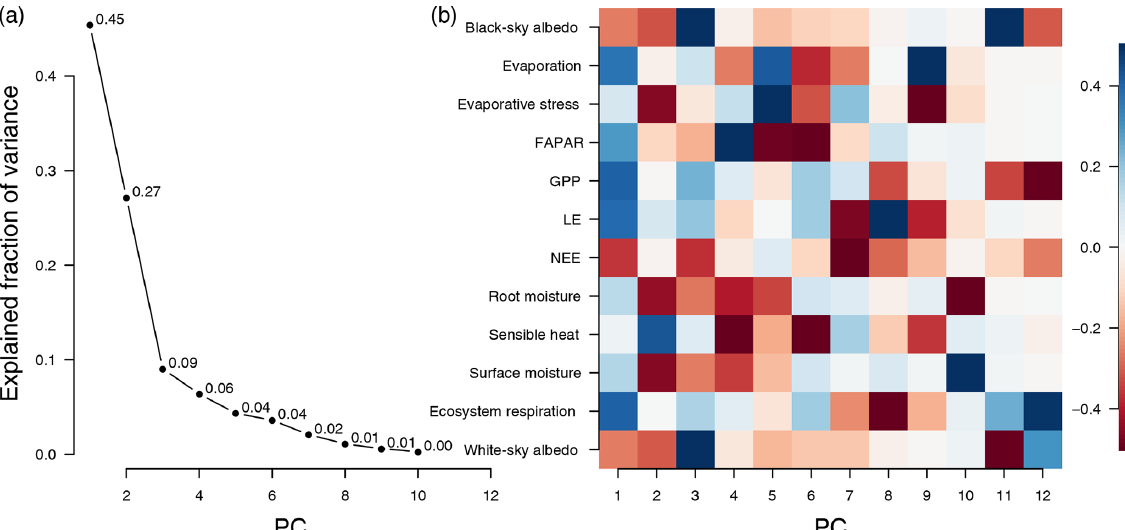
Figure 2. (a) Fraction of explained variance of the PCA by component. The knee at component three suggests that components four and higher do not contribute much to total variance. (b) Rotation matrix of the global PCA model (also called loadings , Eq. 4). The columns of the rotation matrix describe the linear combinations of the (centered and standardized) original variables that make up the principal components. PC 1 is dominated by primary-productivity-related variables, PC 2 by variables describing water availability, and PC 3 by variables describing albedo. Values of the rotation matrix are clamped to the range [ − 0.5, 0.5]; the actual range of the values is [ − 0.73, 0.74] and [ − 0.46, 0.54] for the first three